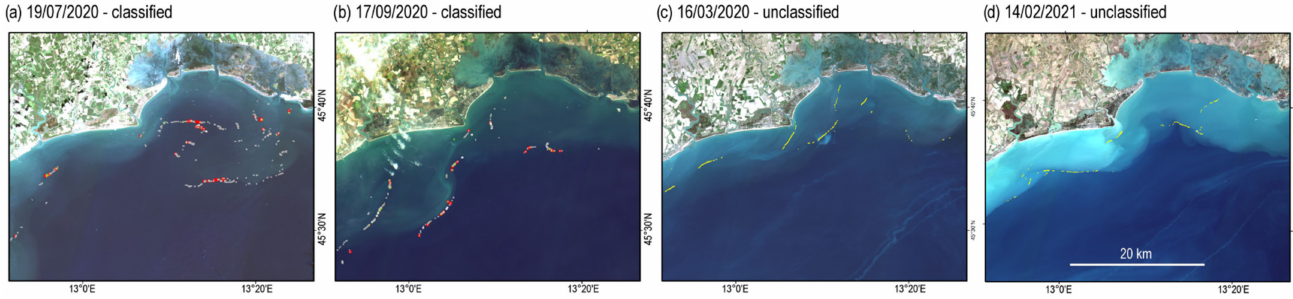
Figure 10. Classified patches in other months of summer 2020, on 19 July ( a ) and 17 September ( b ), and unclassified patches in winter 2020, on 16 March ( c ) and 14 February 2021 ( d